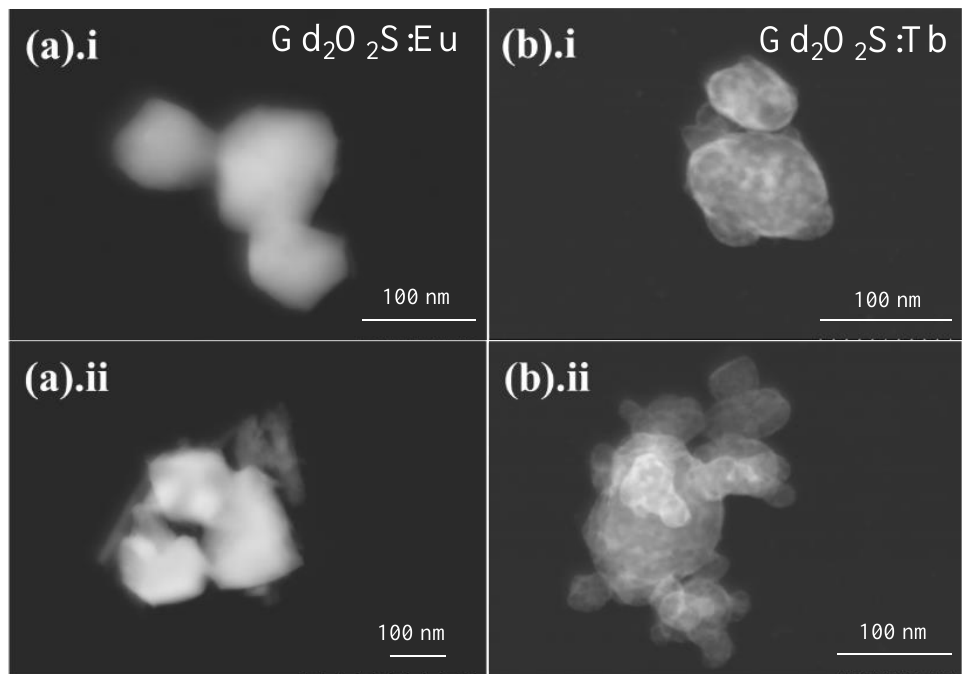
Figure 5. Particles separation via high-speed centrifugation simply using DI water as a dispersive medium. STEM images of nanometer-sized particles separated from 2.5 µm Gd 2 O 2 S:Eu [( a ). ( i , ii )] and 8 – 10 µm average diameter Gd 2 O 2 S:Tb [( b ). ( i , ii )] commercial microparticles (CMPs) via centrifugal sedimentation in DI water.